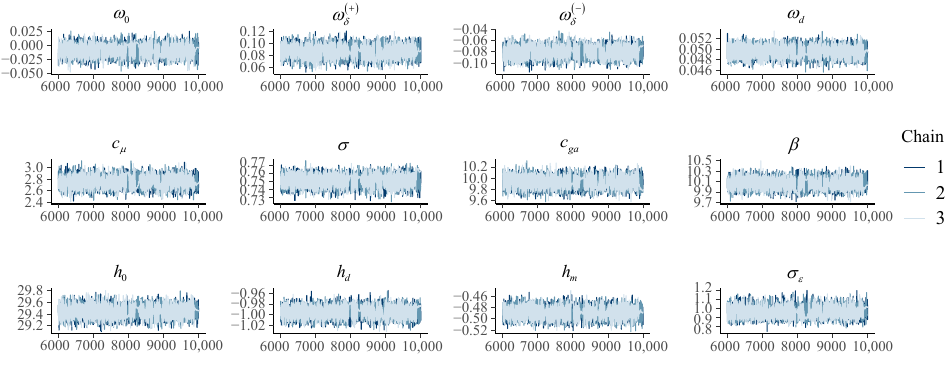
Figure 3. Convergence diagnostics.